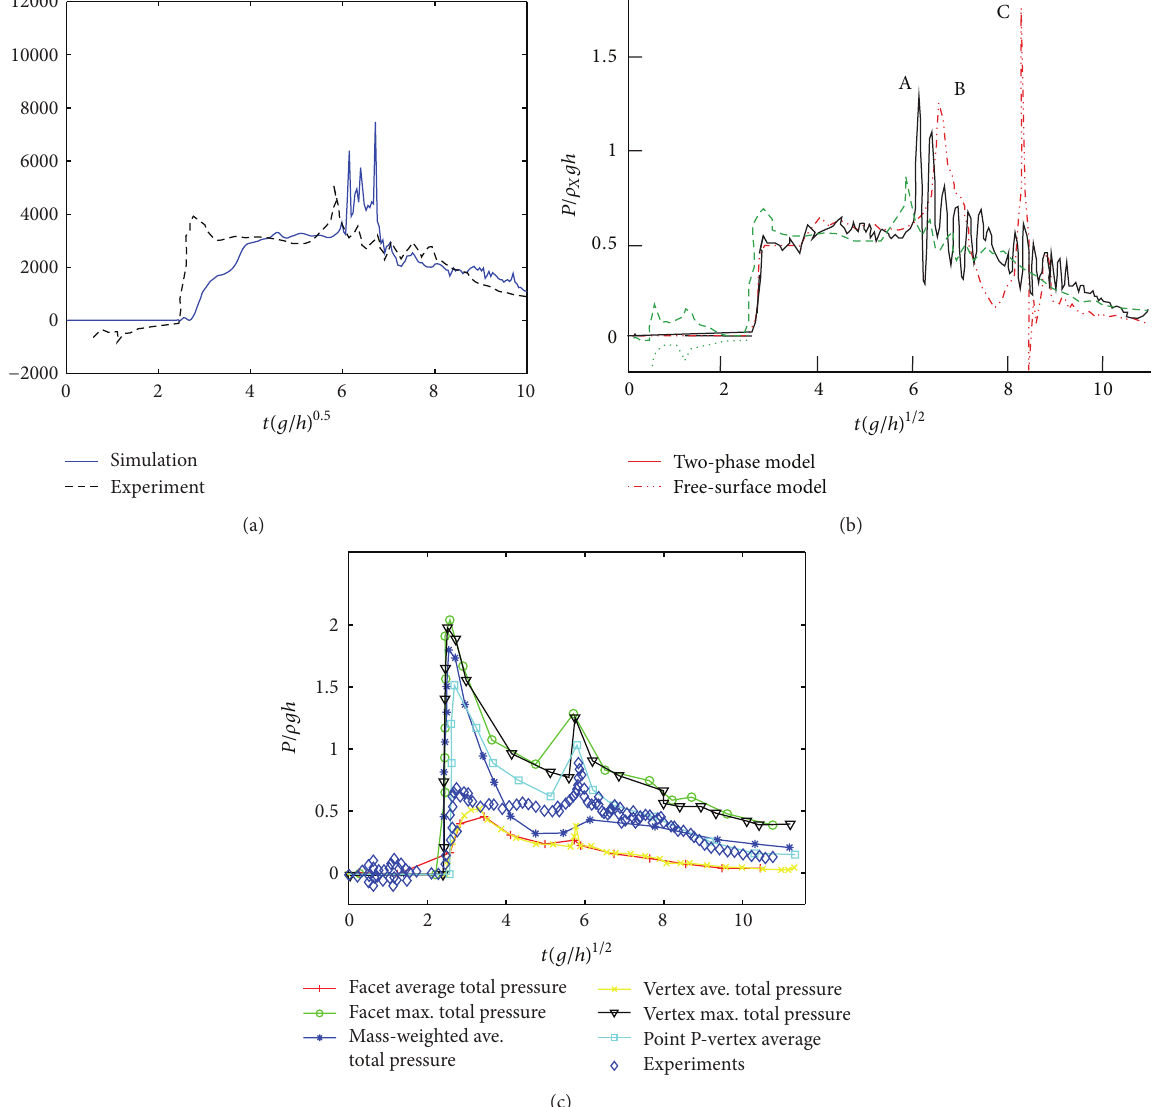
Figure 15: Pressure time history at a measurement point P2 on the right wall: (a) CIP, (b) SPH [28], and (c) Fluent